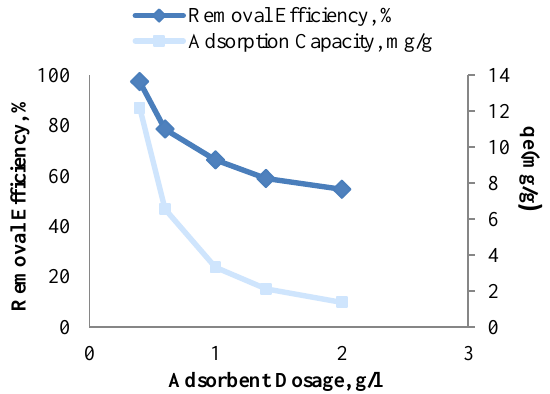
Figure 7. Comparison of the effect of adsorbent dose changes on the removal efficiency of copper using MCh/Fe-Zr nanoparticles (density Cu 2+ = 5ppm, speed = 30 rpm, time = 30 minutes, temperature = 25 o C, and pH = 9)